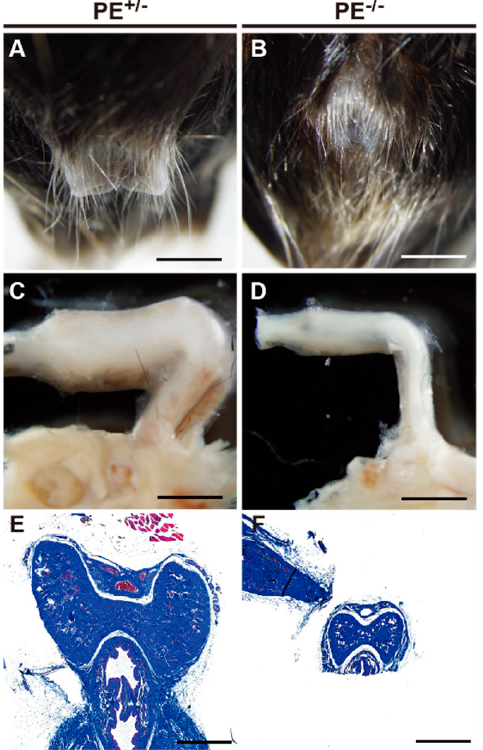
Figure 5. Hypoplastic penis in PE − / − male mice. ( A , B ) Macroscopic view of the penis of control ( A ) and PE − / − ( B ) mice. ( C , D ) Penile foreskin was removed, and penes were compared between control ( C ) and PE − / − ( D ) mice. ( E , F ) Masson-trichrome staining of the penile sections of control ( E ) and PE − / − ( F ) mice. Scale bar: 2 mm in ( A – D ); 500 µ m in ( E , F ).